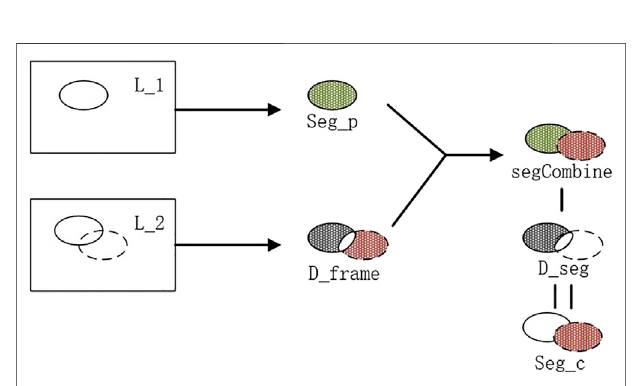
FIGURE 7 | Steps of the inter-frame differential